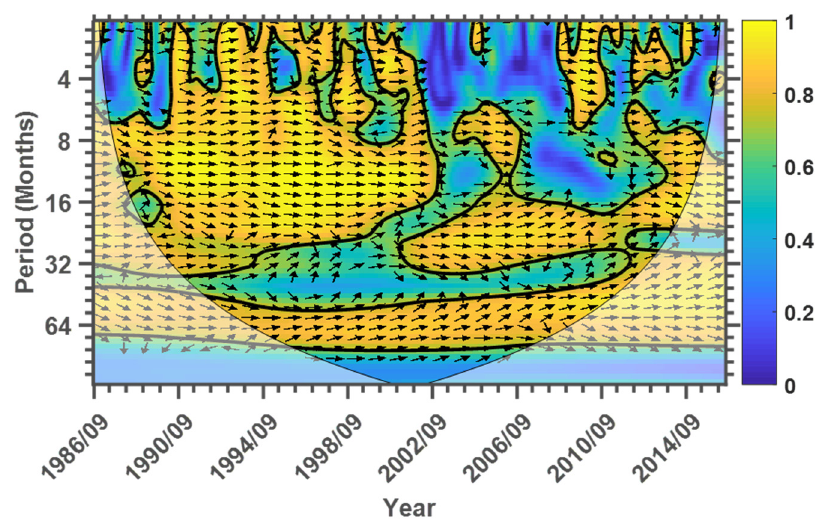
Figure 12. Wavelet coherence between NADI-NDII and NADI-MERRA–2, the phase relationship represented by arrows. The black solid line contour delimits the region (yellow) where the power is string and the cone of influence (solid black line) indicated the 95% confidence level.